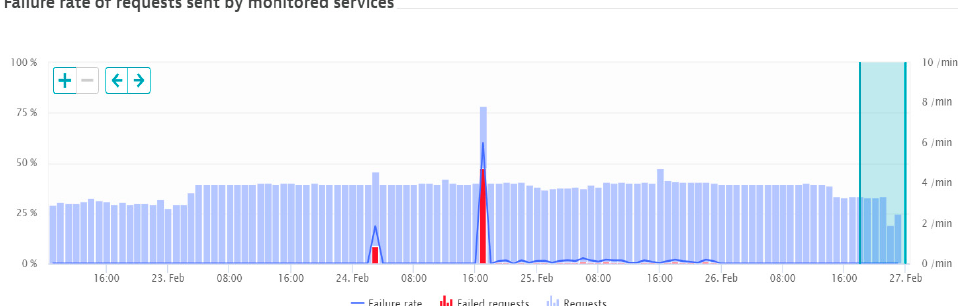
Figure 6. Failure rate of requests in a normal operating period.